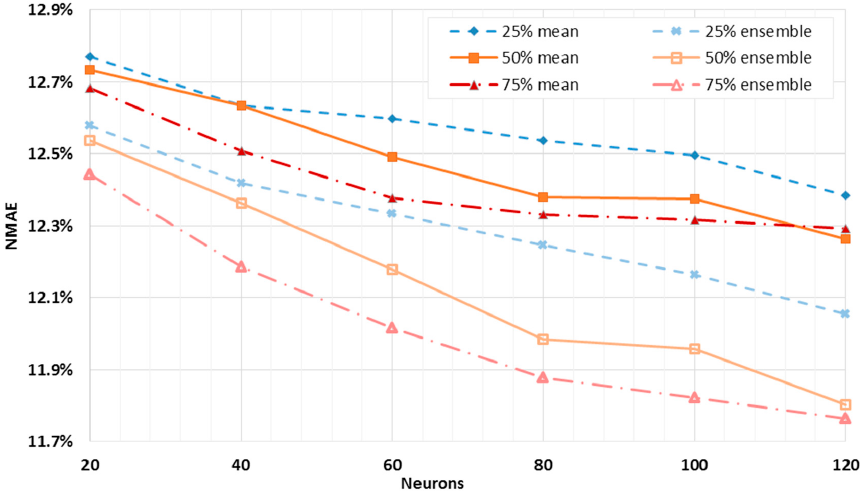
Figure 6. Comparison between the mean NMAE % and the ensemble NMAE % of 50 trials as a function of the hidden layers’ sizes, kept with a constant ratio of neurons.